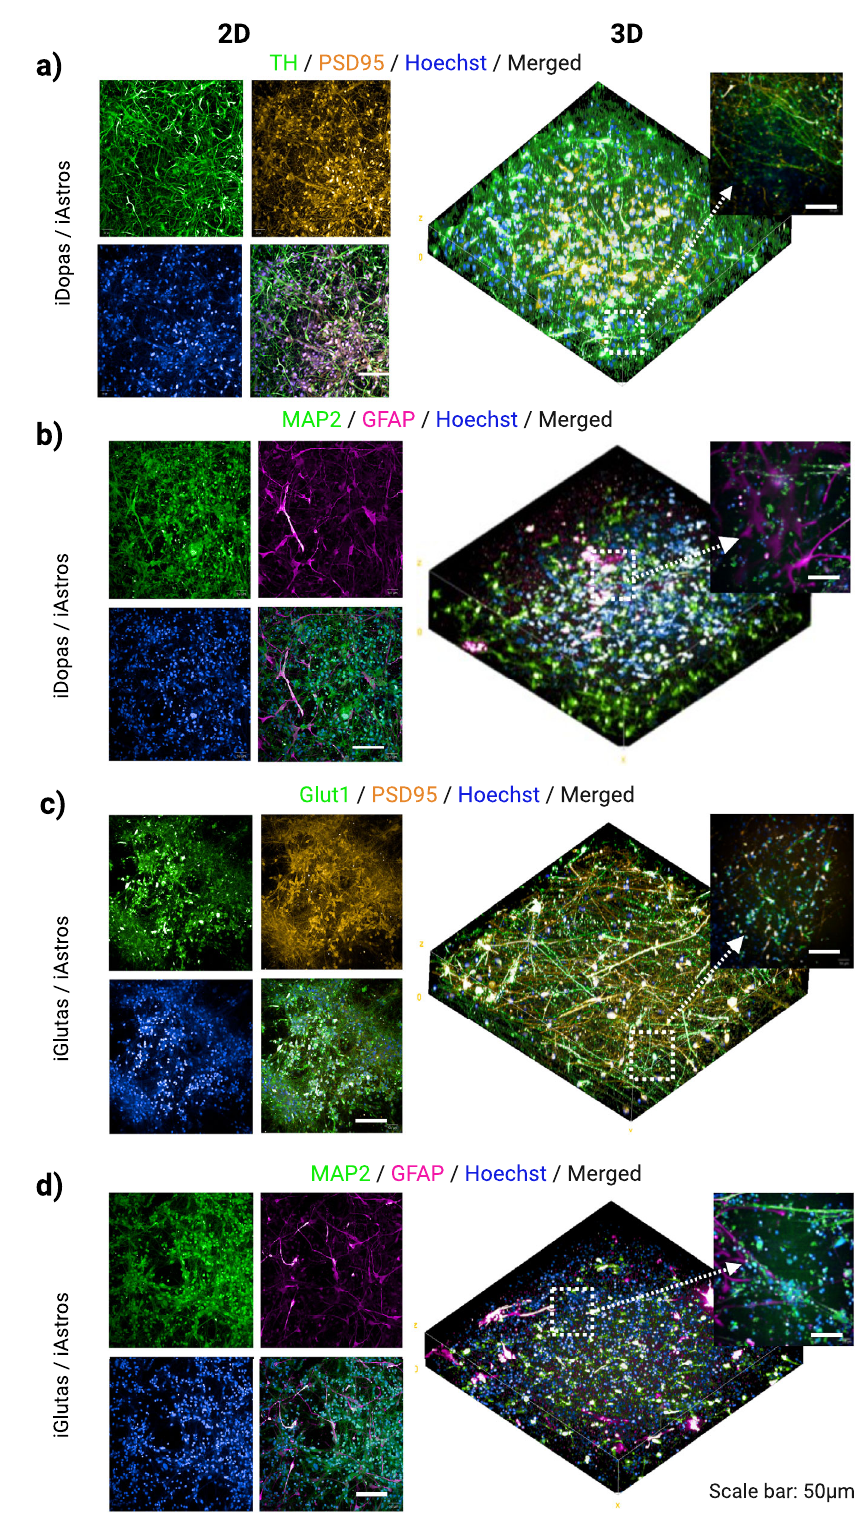
neuronal calcium traces and cumulative data on peak frequency and peak amplitude from basal, basal after D-serine treatment, evoked and evoked after D-serine treatment groups are shown in Fig. 4g – i and 4j – l for the 2D and 3D models, respectively. The corresponding td-Tomate fl uorescence images of ChrimsonR expression are shown in Supplementary Fig. 4c and d for 2D and